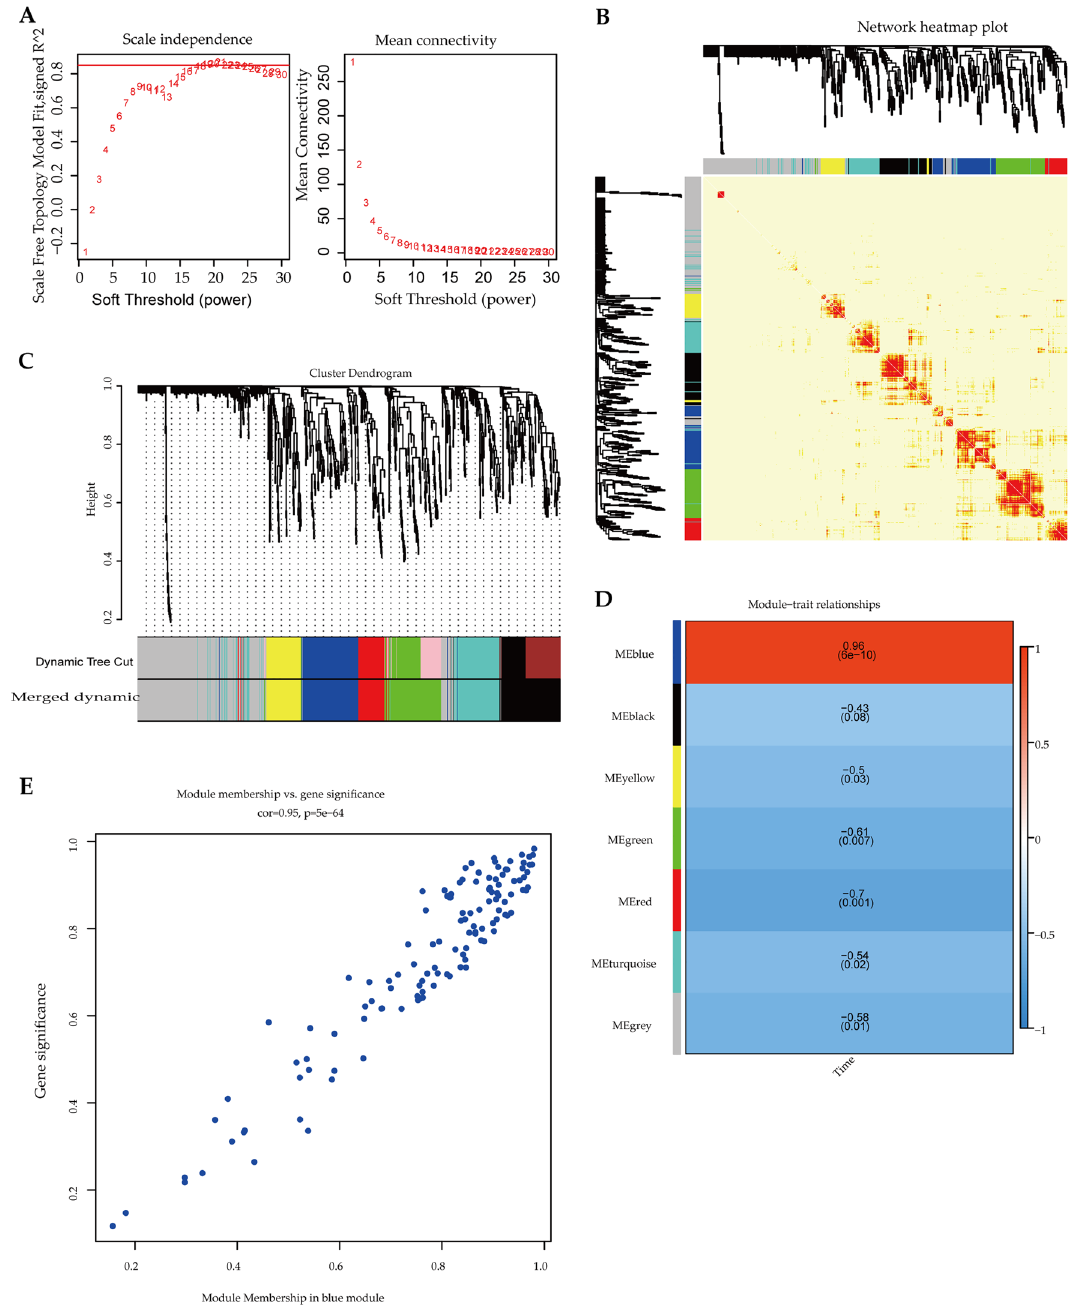
Figure 2. Construction of WGCNA analysis using BMKCloud (www. biocl oud. net). ( A ) The soft-threshold power versus scale-free topology model fit index and mean connectivity. The left image shows the scale-free fit index (y-axis) as a function of the soft-thresholding power (x-axis). The right image shows the average connectivity (degree, y-axis) as a function of the soft-thresholding power (x-axis). ( B ) Heat map of the correlation between modules and traits. ( C ) Module clustering tree. ( D ) Heatmap shows correlations of module- related genes and the treatment time of pine sawdust. ( E ) A scatter plot of gene significance (GS) vs. module membership (MM) in the blue